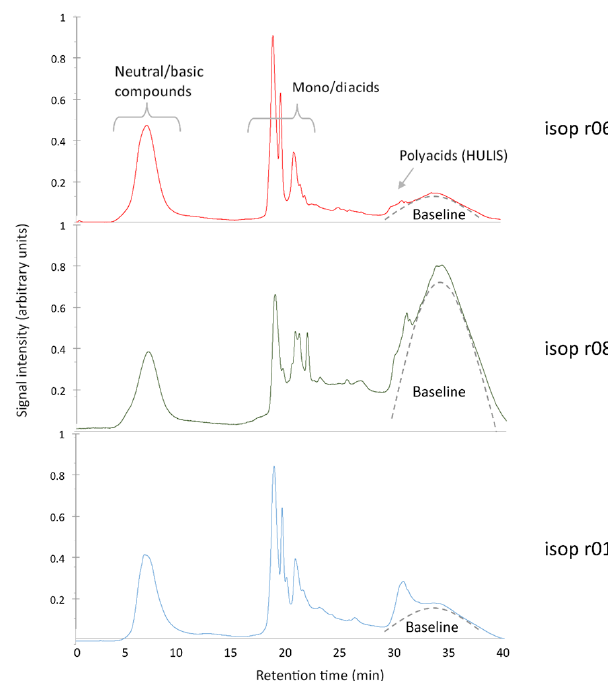
Figure 6. HPLC chromatograms of isoprene SOA water ex- tracts. Chromatographic features are grouped into neutral, mono- /dicarboxylic acid, and polycarboxylic acid classes based on their affinity for the column phase. Sample identifications are provided in Table 2.